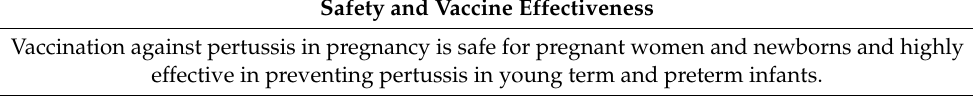
Table 1. Global Pertussis Initiative Statement on Vaccination Against Pertussis in Pregnancy. Safety and Vaccine